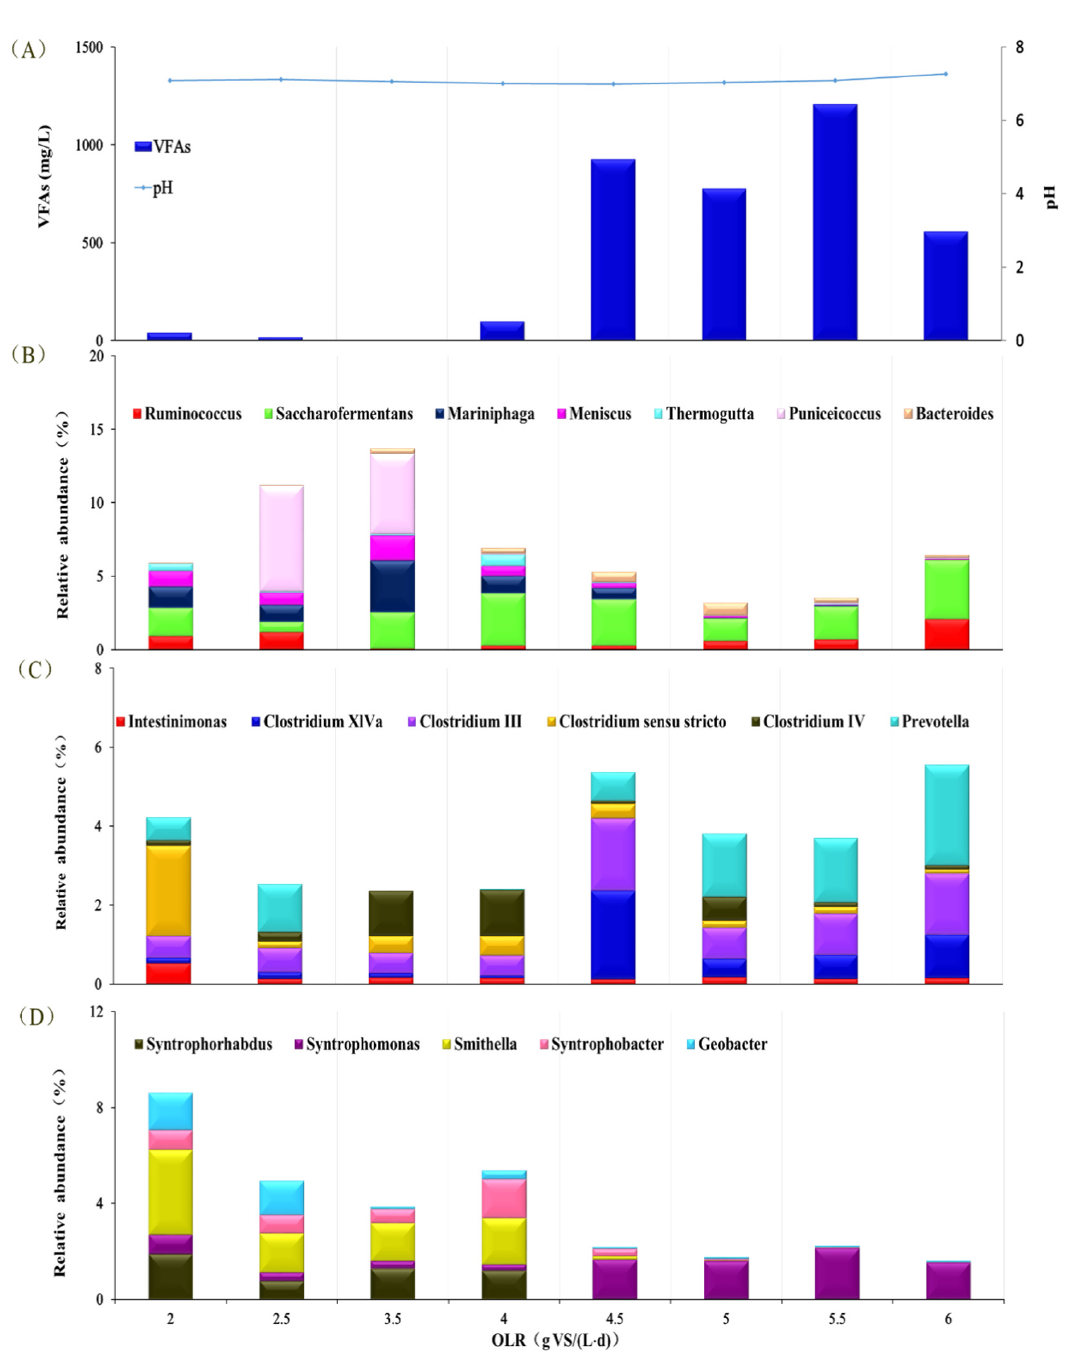
Figure 4. The pH, VFAs concentration and the bacteria in genus level for GM31. ( A ) The values of pH and VFAs during the process. ( B ) The bacteria participated in the hydrolysis/acidogenesis phase. ( C ) The bacteria contributed to the accumulation of VFAs. ( D ) The bacteria involved in converting Pa and Ba.